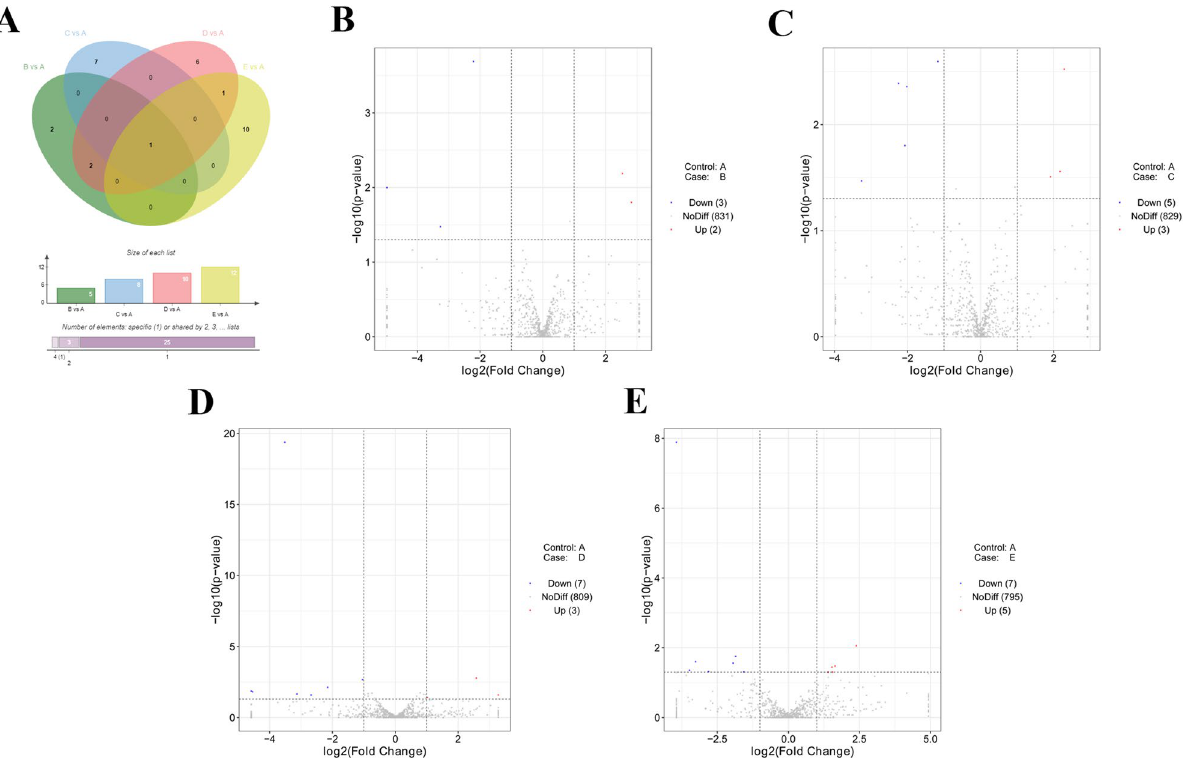
Figure 2. Identification of DE miRNAs. ( A ) Venn diagram of DE miRNAs in B vs A, C vs A, D vs A, and E vs A groups. ( B – E ) Volcano plot of miRNA expression patterns in B vs A ( B ), C vs A ( C ), D vs A ( D ), and E vs A ( E ) groups. Venn plot was drawn by jvenn website (http:// jvenn. toulo use. inra. fr/ app/ examp le. html) 51